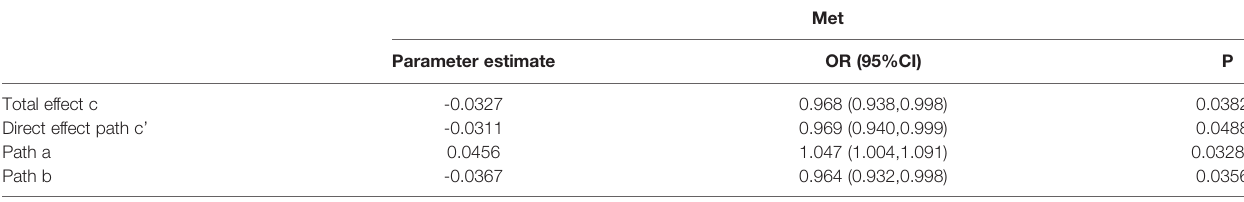
TABLE 4 | Mediation analysis of the relationship between Met and DR by Hcy.